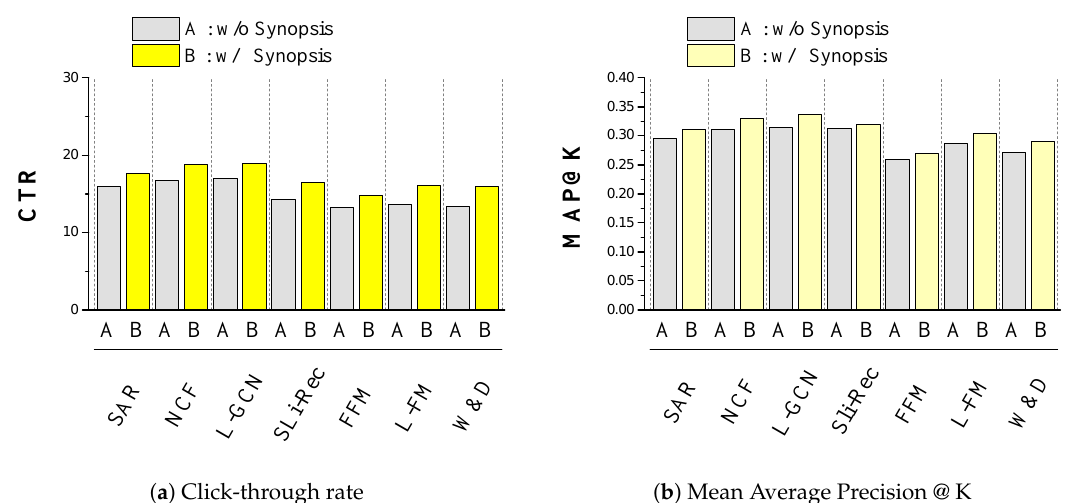
Figure 12. Visualization of A/B experiments for narrational information ( Yahoo dataset).